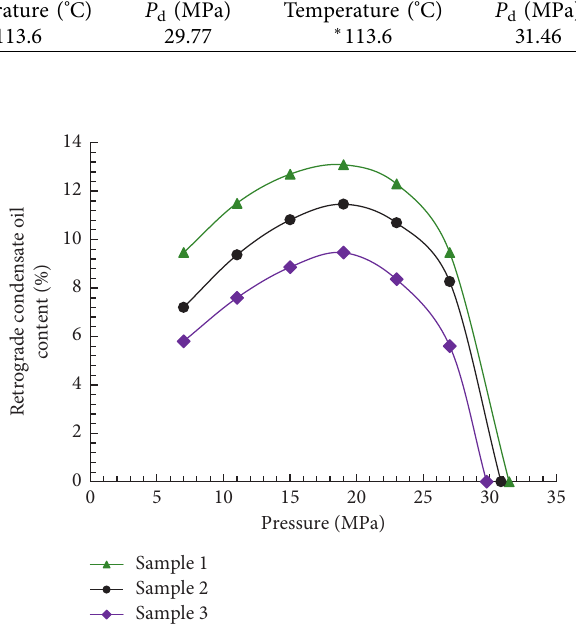
2 Figure 4: The relationship diagram between retrograde condensate liquid volume and pressure of condensate gas with different CO 2 content.